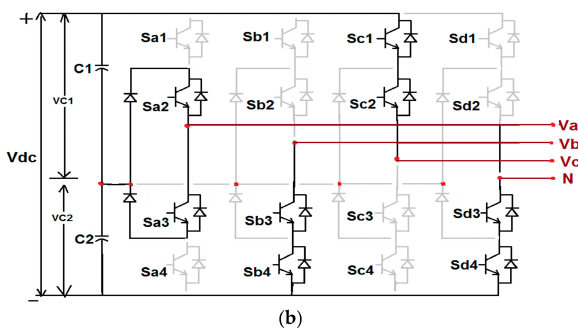
Figure 3. Modes of operation of 3-phase 4-leg 3-level NPC inverter ( a ) PPNP; and ( b ) ONPN.